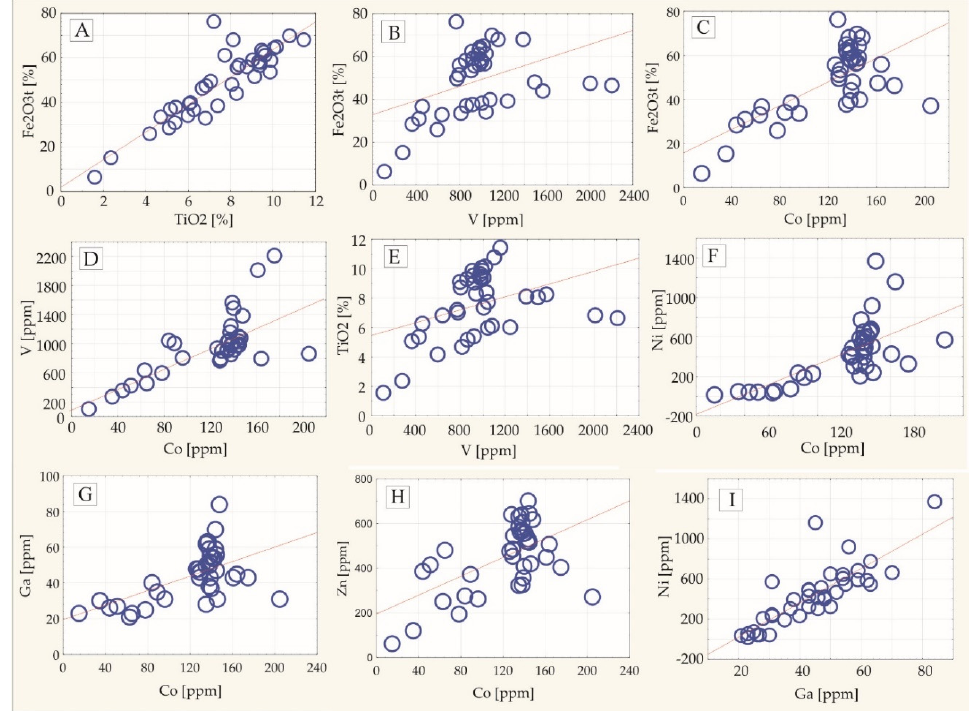
Figure 16. Bivariate diagrams of trace elements with trend lines in magnetite-ilmenite ores from the Krzemianka and Udryn Fe-Ti-V deposits on the Suwałki Anorthosite Massif in NE Poland. ( A ) TiO 2 vs. Fe 2 O 3 t; ( B ) V vs. Fe 2 O 3 t; ( C ) Co vs. Fe 2 O 3 t; ( D ) Co vs. V; ( E ) V vs. TiO 2 ; ( F ) Co vs. Ni; ( G ) Co vs. Ga; ( H ) Co vs. Zn; ( I ) Ga vs. Ni. Note: the line of best fit is shown as the red line.